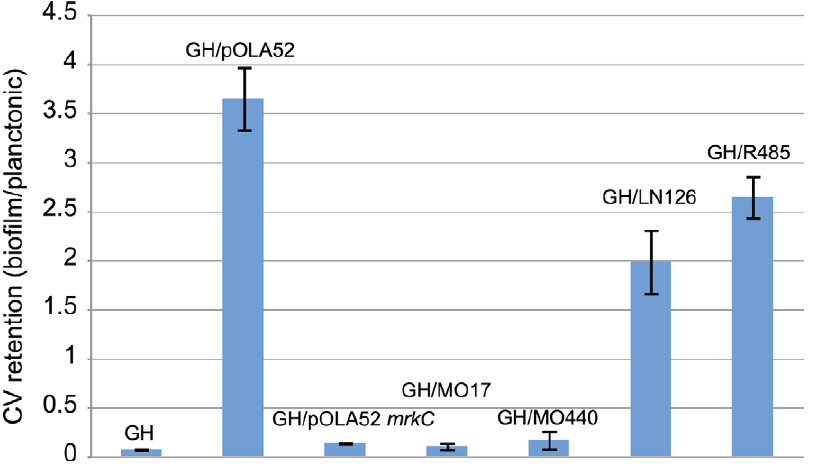
Figure 4. Biofilm induction by IncX-plasmids containing fimbrial gene cassettes. Biofilm formation measured via a crystal violet retention assay in E. coli Genehogs (GH) carrying pOLA52 compared with that of plasmids pMO17_54, pMO440_54, pLN126_33 and R485, respectively. The mrkC mutant of pOLA52 has a disrupted Usher protein-encoding gene and can therefore not produce biofilm. Error bars are standard deviations ( n =4).